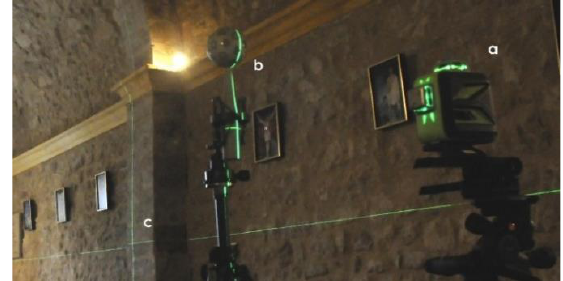
Figure 1 : The Eigenmike spherical array of 32 microphones ( b ), aligned vertically on the survey protocol’s spatial grid, and an intersection of laser beams used for the scaling step ( c ).